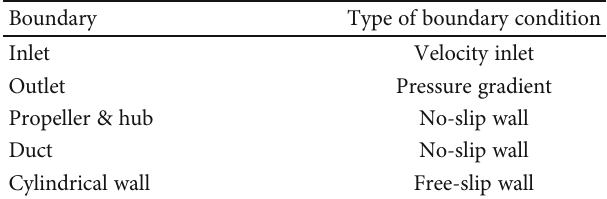
Table 3: Boundary